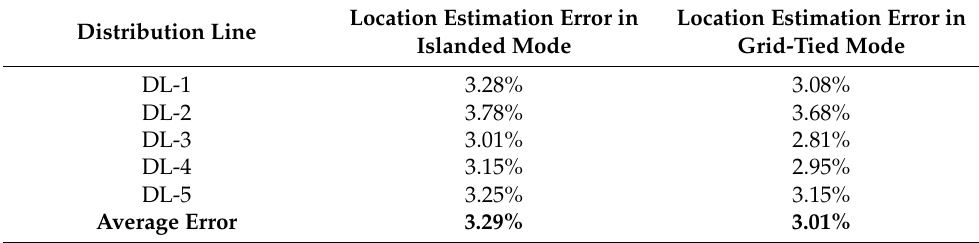
Table 5. Perfomance of the fault location unit of the proposed NIPS on each line of the IEC MG.